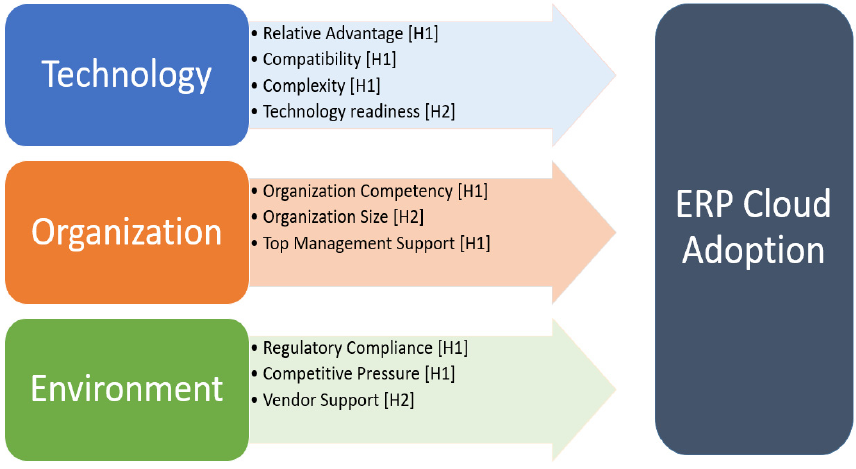
Figure 7. Research Figure 7. Research model.